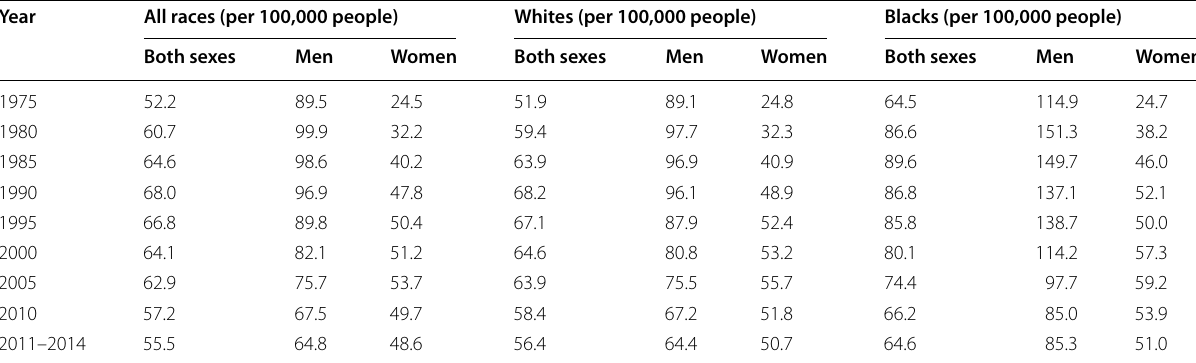
Table 2 Age-adjusted rate of lung cancer incidence in the United States (1975–2014) Year All races (per 100,000 people)